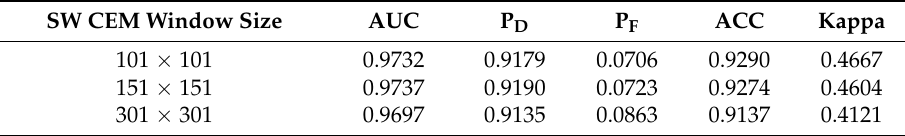
Table 7. Detection results of SW CEM with various window sizes.